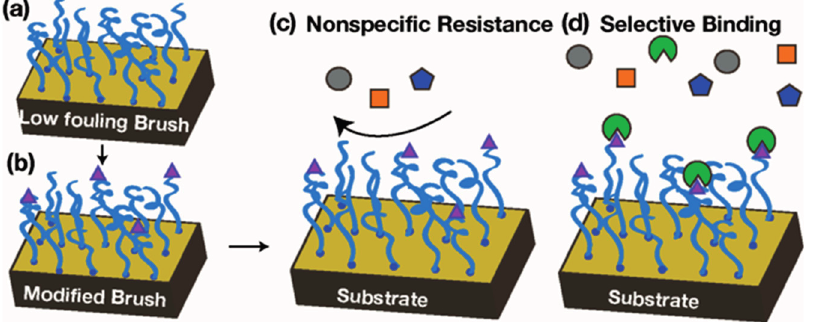
Figure 11. Schematic depiction of ( a ) low fouling polymer brush (blue lines) that is ( b ) modified with a functional molecule (purple triangles); ( c ) The functional molecules on the polymer brush do not interfere with nonspecific protein adsorption from the protein solution (circles and squares) above the brushes but allow for ( d ) selective binding of a target molecule from the